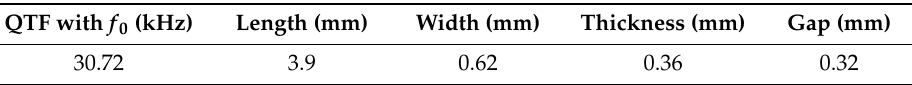
Table 1. Parameters of custom QTF